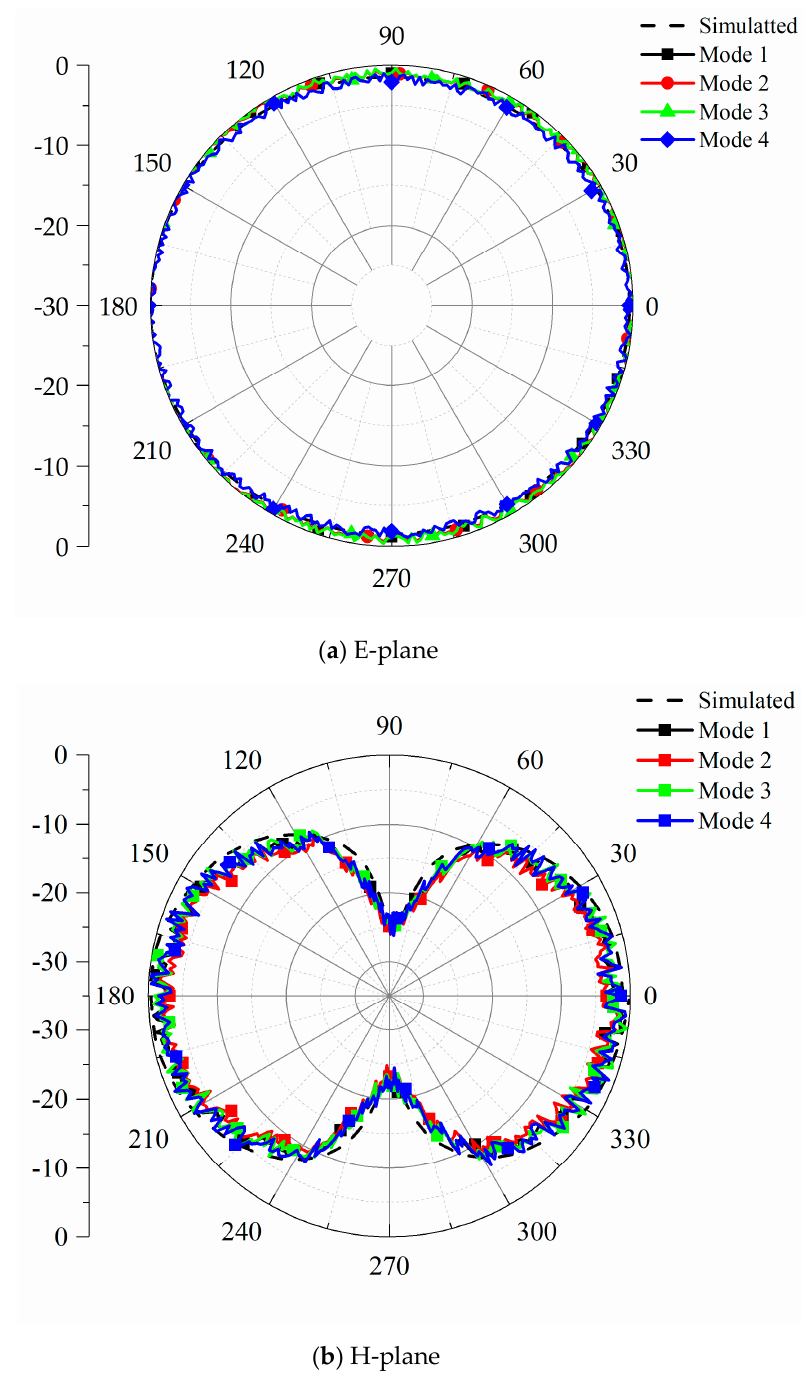
Figure 9. Measured radiation patterns of the proposed structure at 1.5 GHz.